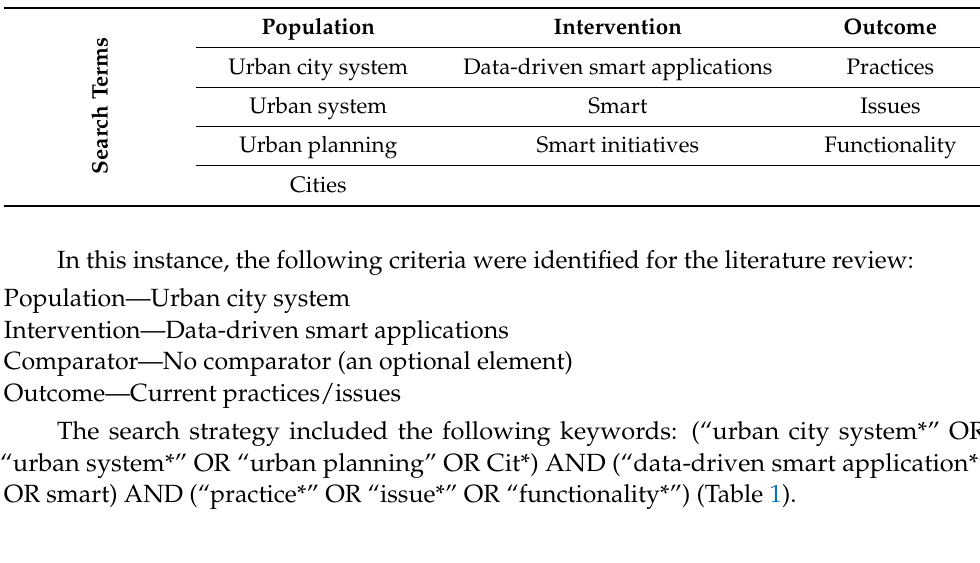
Table 1. Logic grid with identified